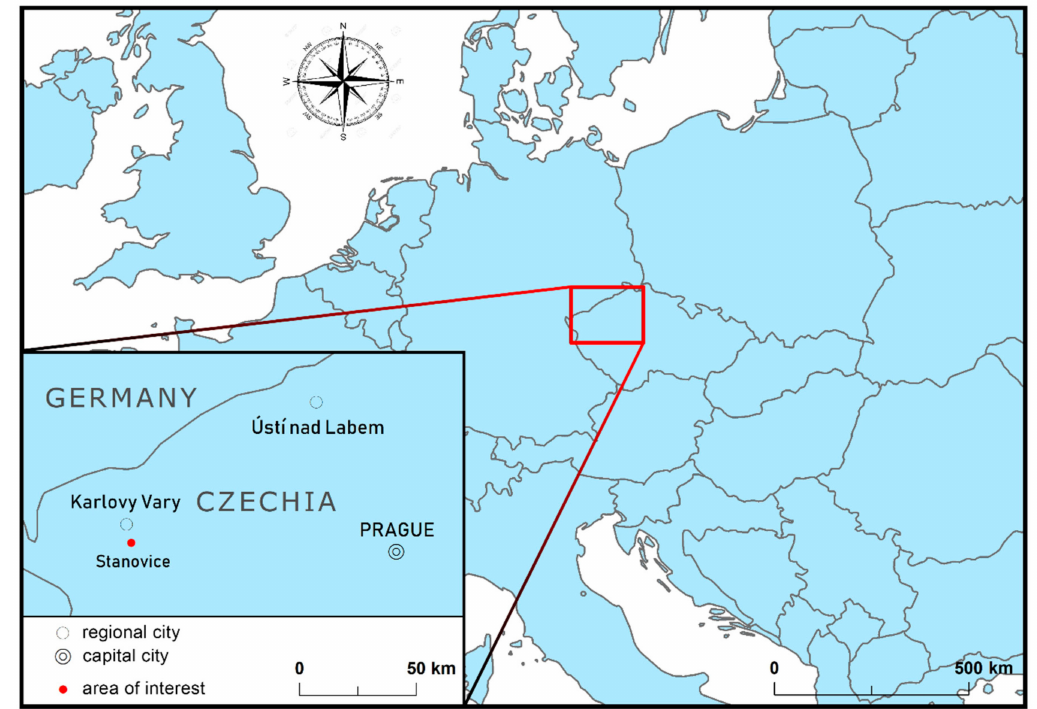
Figure 1. Location of Stanovice water